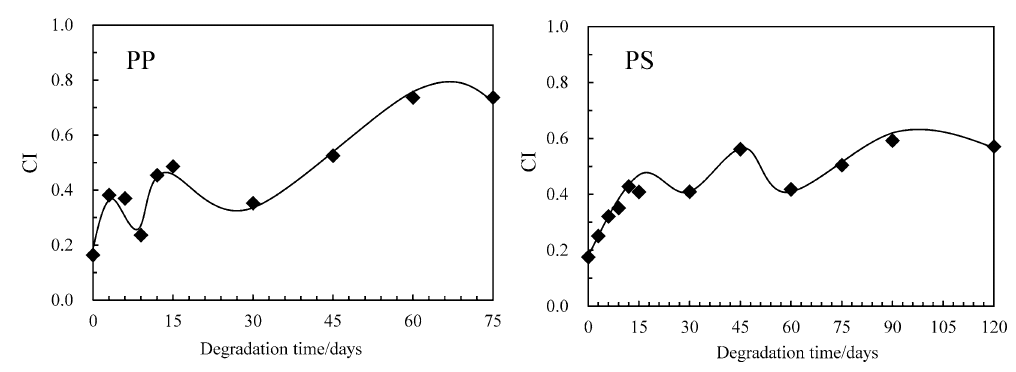
Figure 3. Value of carbonyl index (CI) change vs degradation